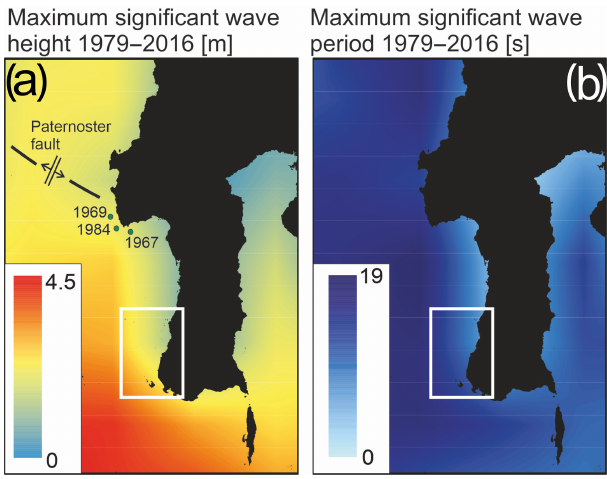
Figure 8. Maximum significant wave height (a) and period (b) extracted from the CAWCR wave hindcast (Durrant et al., 2013, 2015). Panel (a) shows the approximate location and year of the three historical tsunami records reported by Prasetya et al. (2001); their Fig. 1. Faultline and axis of spreading of the Paternoster fault are derived from Prasetya et al. (2001); their Fig. 5. The box delim- ited by the white line indicates the approximate location of Fig. 7 within this figure. CAWCR source: Bureau of Meteorology and CSIRO Copyright